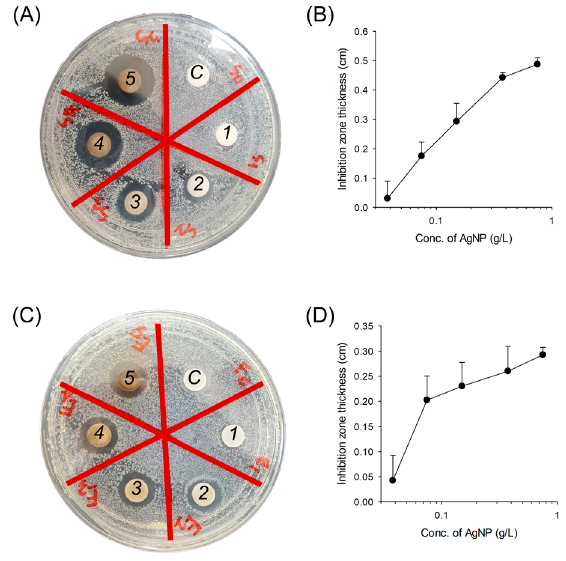
Figure 4. Antibacterial activity of AgNPs against bacterial strains. Antibacterial activity of AgNPs against ( A ) S. aureus and ( C ) E. coli determined by the disk diffusion method. The quantification of inhibition zone thickness for the result of disk diffusion test against ( B ) S. aureus and ( D ) E. coli ( n = 3). C = control, distilled water. Areas 1–5 = AgNPs at concentrations of 38, 75, 150, 375, and 750 mg L − 1 AgNPs, respectively.